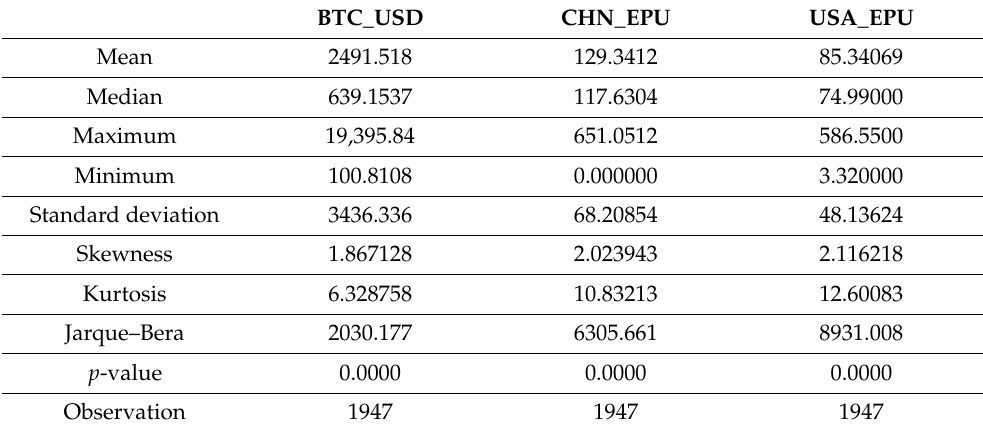
Table 1. Descriptive